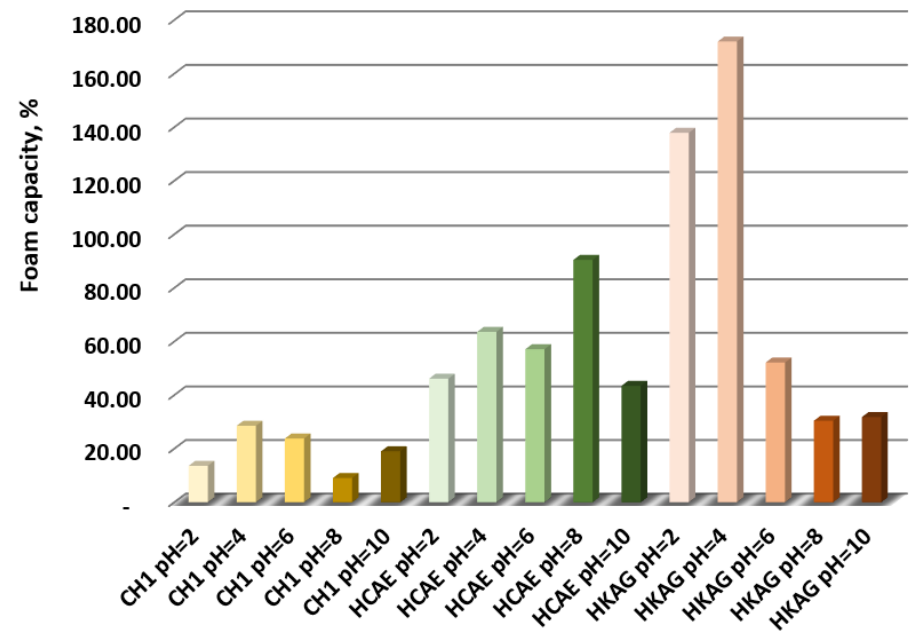
Figure 5. The foaming capacity of the protein hydrolysates. The foam stability presented in Table 2 also shows a dependency on pH value and a more stable keratin hydrolysate foam as compared to collagen hydrolysates foams. The ATR-FTIR spectroscopy analysis results are presented in Figure